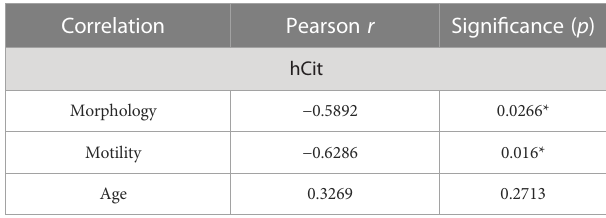
sperm exocytosis, and semen viscosity (Figure 2B). The proteins within these categories organized by their SP molecular function and their respective Cit levels in non-NZ and control subjects are shown in Figure 2C. Of note, the protein dipeptidyl peptidase-4 (DPP-IV) was the candidate that showed the major signi fi cant mismatch in terms of downregulation of its Cit levels between non- NZ and controls, as shown in Figure 2C. Other relevant proteins signi fi cantly downregulated in their citrullination levels in sEVs of non-NZ subjects include semenogelin-2 (SEMG2), heat shock cognate 71 (HSP7C), Ras oncogene 27A (RAB27A), Annexin 2 (ANXA2), transglutaminase 4 (TGM4), lactotransferrin (LTF), and the carboxypeptidase E (CBPE) (Figure 2C).